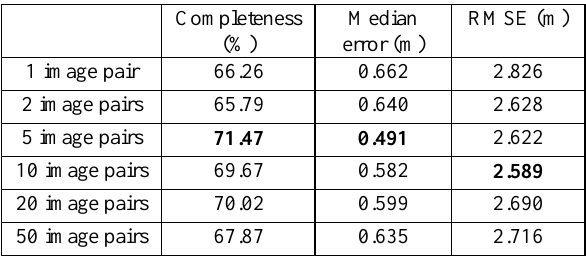
Table 1. Evaluation results of the fused point clouds generated from different number of stereo image pairs